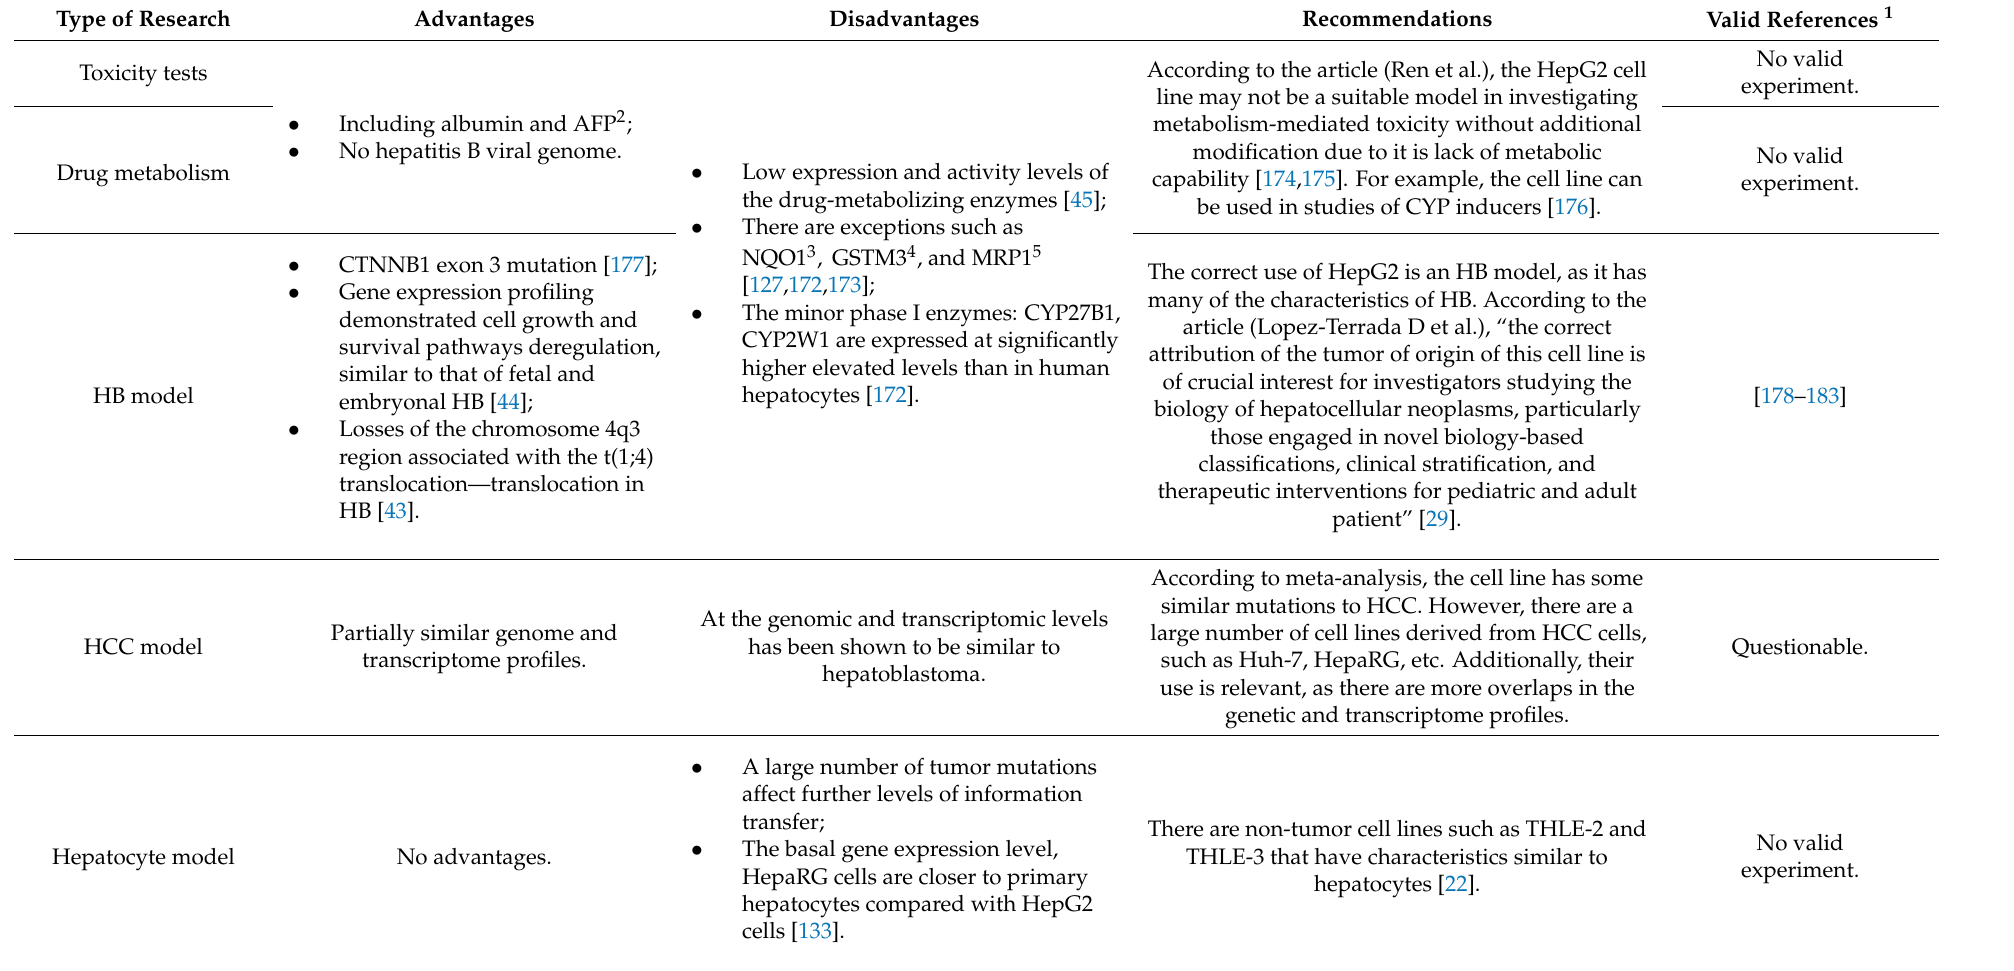
Table 3. Suitability of the HepG2 cell line in various spheres of biomedical